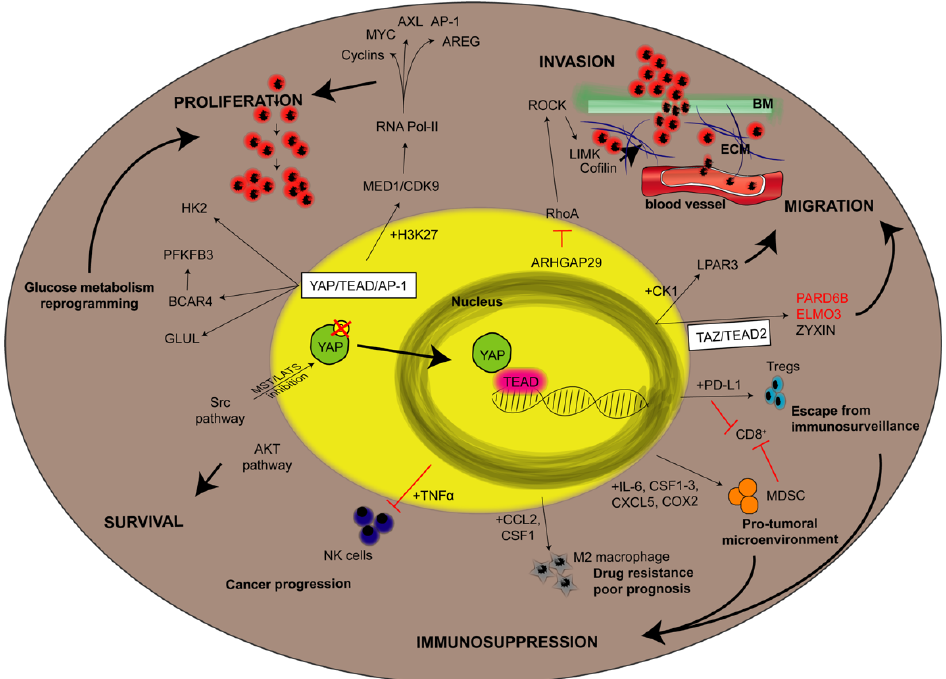
Figure 3. YAP downstream targets in cancer cells. The figure aims to give an overview about the downstream targets of YAP involved in a given step of cancer development taking into consideration studies led in vitro, in vivo and referring also to some correlations with poor prognosis in human patients. Steps of cancer development (indicated in bold uppercase) are proliferation, survival, invasion, migration and immunosuppression. They are linked to a given pathway by black bold arrows. Thin black arrows indicate either YAP-dependent protein overexpression (if the protein is reported in black) or protein downregulation (if reported in red). If the molecular pathway involves the contribution of additional YAP-dependent proteins expression, they are reported close to the arrows and preceded by “+”. Otherwise, red lines mean a block or an inhibition of a given pathway. AP-1: activator protein-1; AREG: amphiregulin; ARHGAP29: Rho GTPase activat-